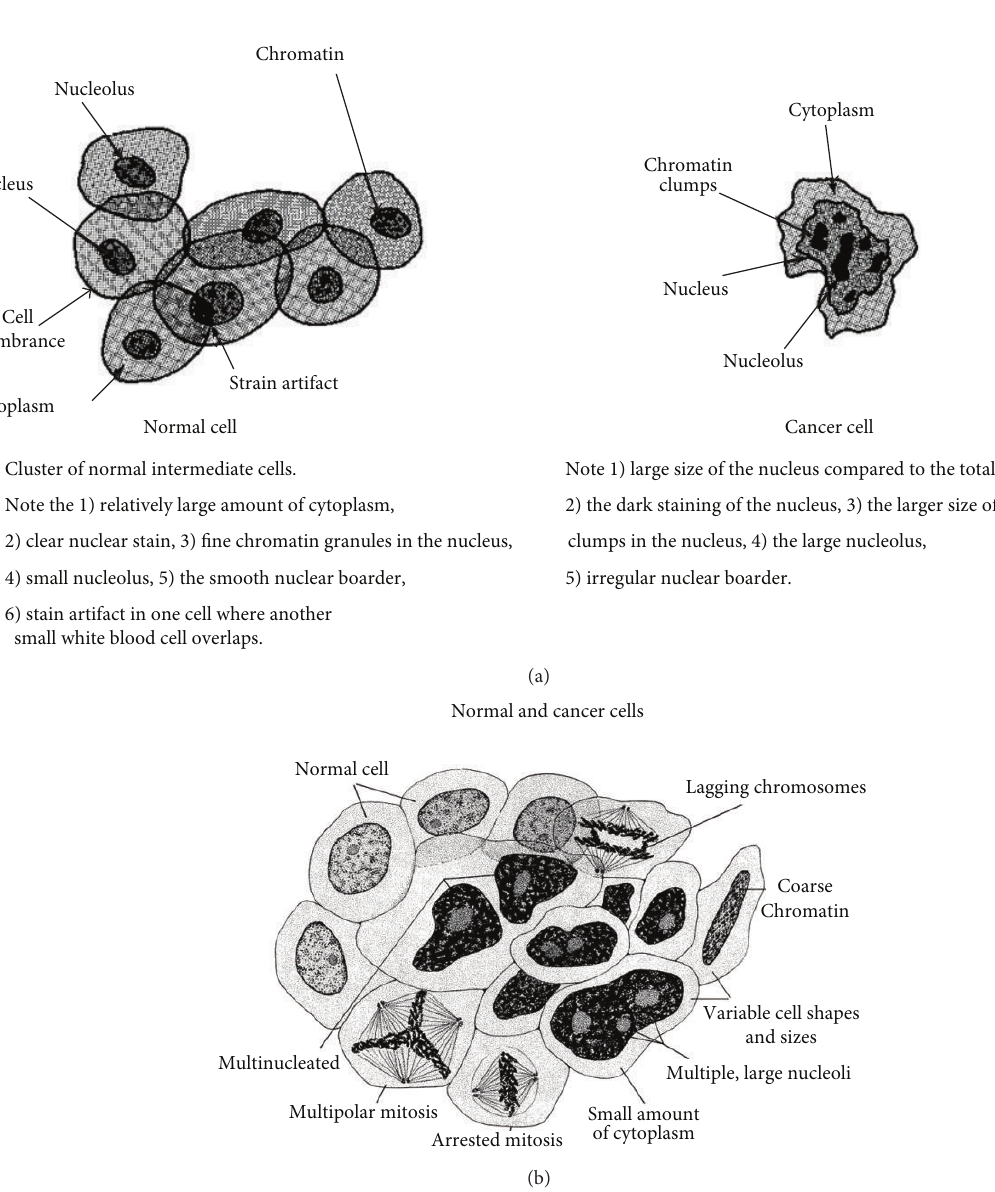
Figure 6: (a) Graphics and description comparing normal round cells and cancer cells with both irregular nuclear and plasma cell membranes (With permission from the National Institutes of Health/Department of Health and Human Services). (b) The round normal and cancerous characteristics with warped irregular borders are identified. (With permission from the National Institutes of Health/Department of Health and Human